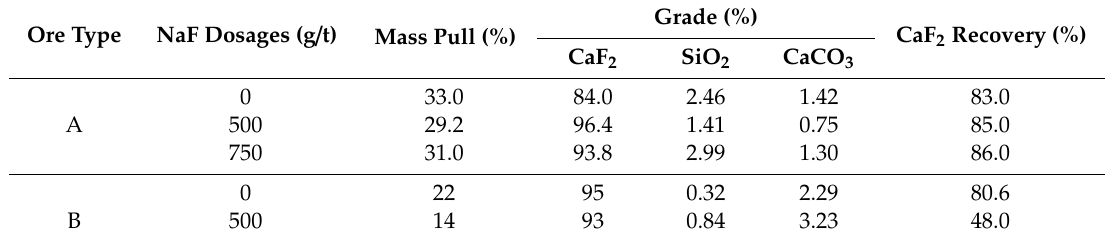
Table 6. E ff ect of fluorite activation using NaF on CaF 2 grade and recovery for ore A and